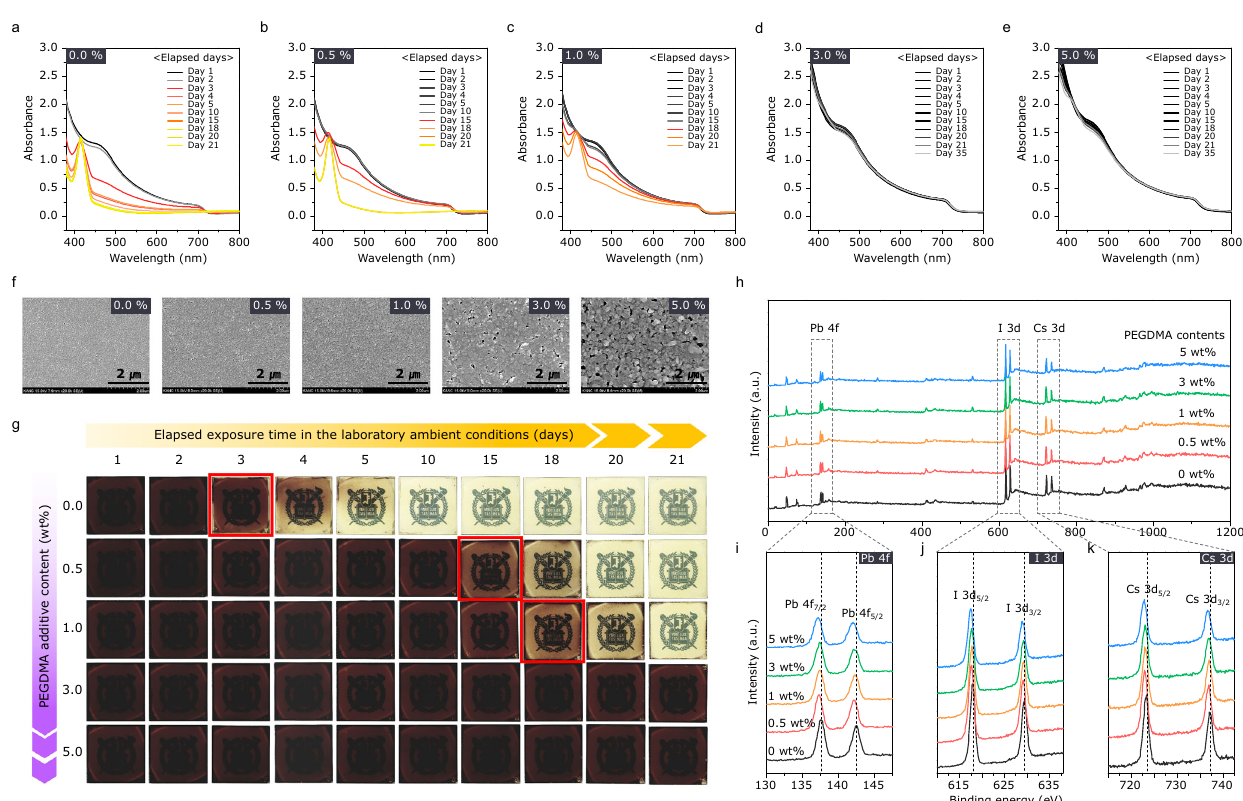
Fig. 3 The effect on the optical long-term stability of γ -CsPbI 3 by splitting the PEGDMA content added to the CsPbI 3 precursor solution. a – e Accumulated UV – vis absorbance spectra while exposing γ -CsPbI 3 (0, 0.5, 1, 3, and 5 wt% PEGDMA) to the ambient conditions for 35 days. f FE-SEM top view images of γ -CsPbI 3 (0, 0.5, 1, 3, and 5 wt% PEGDMA). Scale bar: 2 μ m. g Time-dependent photographic results obtained by observing the optical color change of the γ -CsPbI 3 (0, 0.5, 1, 3, and 5 wt% PEGDMA) thin fi lms during 35 days in ambient conditions. The red square box represents the limitation of γ -phase stability that begins to transition from the γ -phase to the δ -phase. h – k XPS analysis on the fresh γ -CsPbI 3 (0, 0.5, 1, 3, and 5